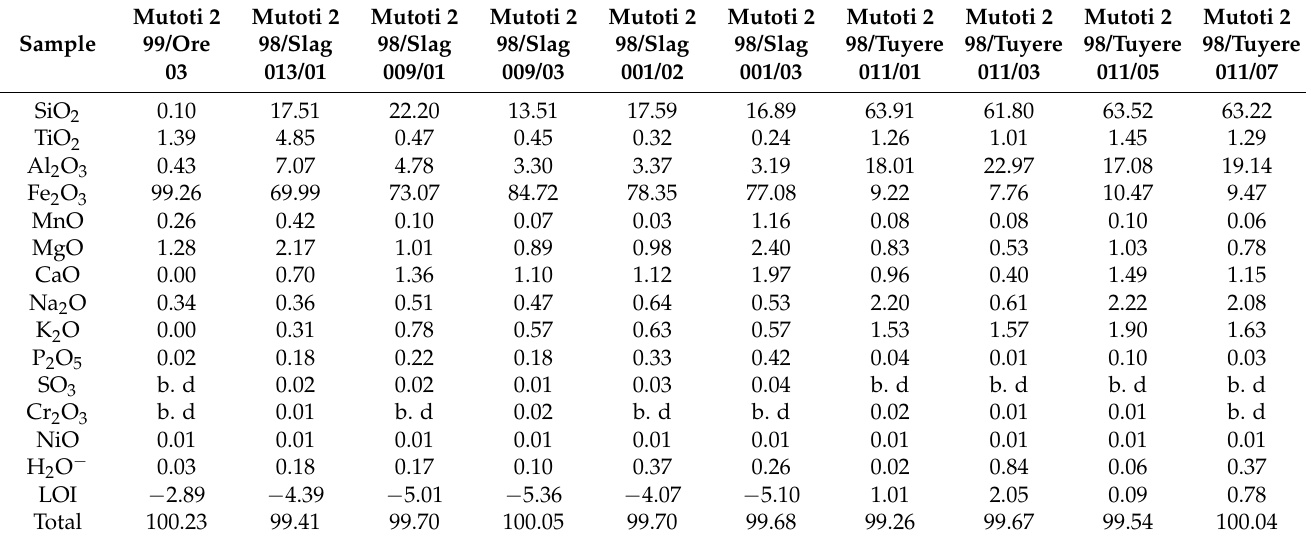
Table 1. WD-XRF readings for iron production debris recovered from Mutoti